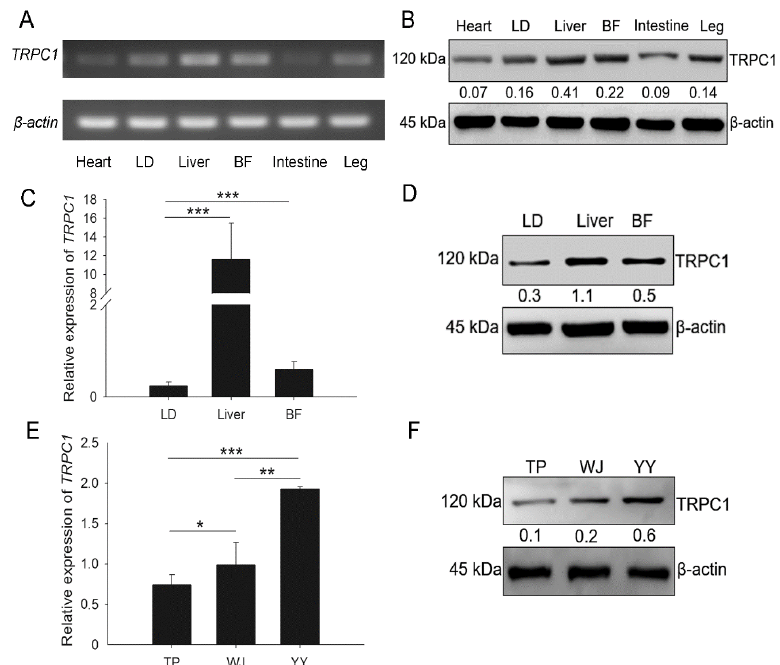
Figure 1. TRPC1 is involved in the growth of pigs. TRPC1 expression in different tissues of TP pigs at the embryonic stage by SqRT-PCR ( A ), WB ( B, D ), and qRT-PCR ( C ). The TRPC1 mRNA ( E ) and protein ( F ) expression levels in the LD of three pig breeds. LD, longissimus dorsi ; BF, back fat; TP, Tibetan pig ( n = 6), WJ, Wujin pig ( n = 6), YY, Yorkshire ( n = 6). Each bar represents the means ± SD. * P < 0.05, ** P < 0.01, *** P < 0.001.